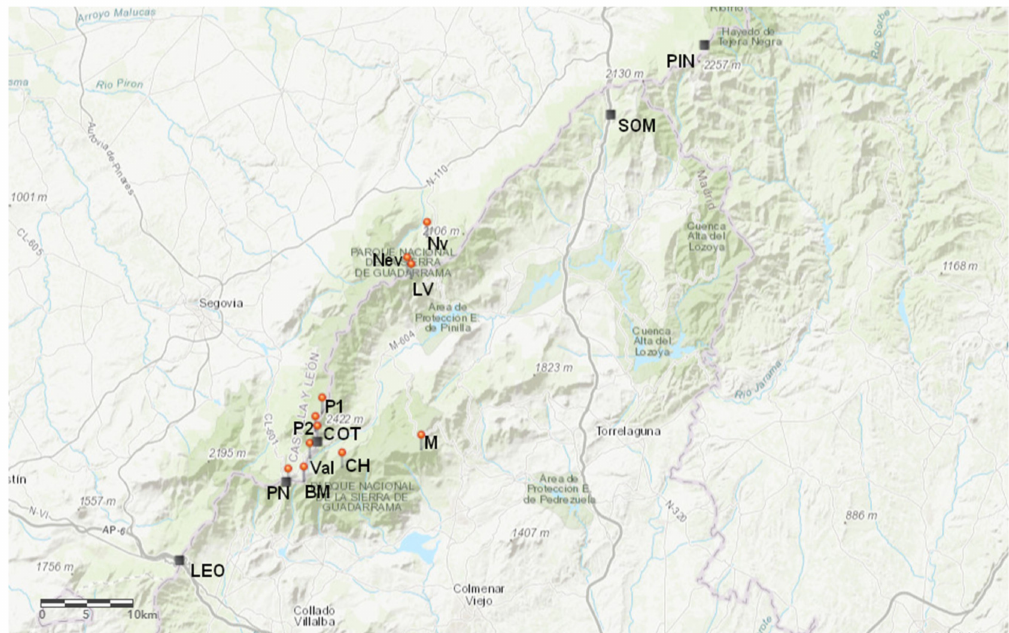
Figure 5. Location of sampling points (red points) and meteorological stations (black squares)